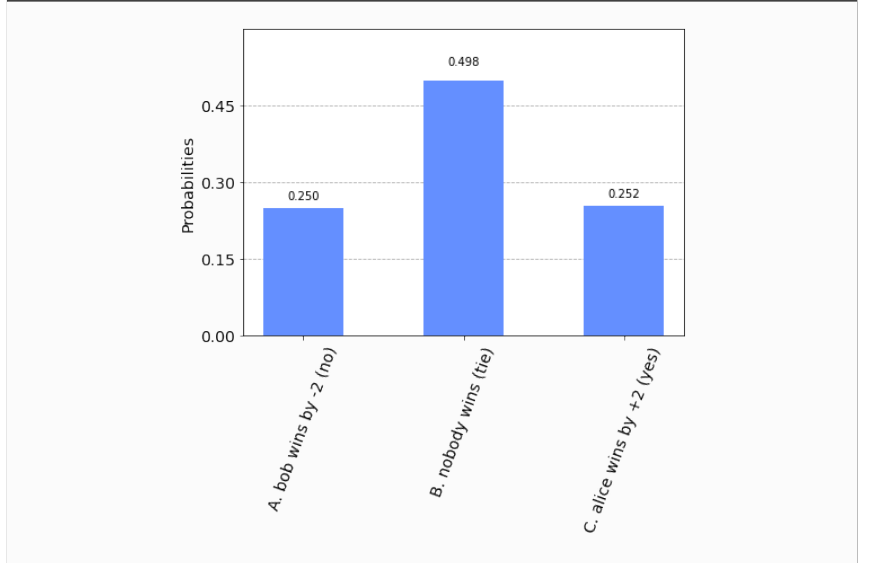
Figure 24. The three possible outcomes when n A = n B = 6, r A = r B = 0, and n I =